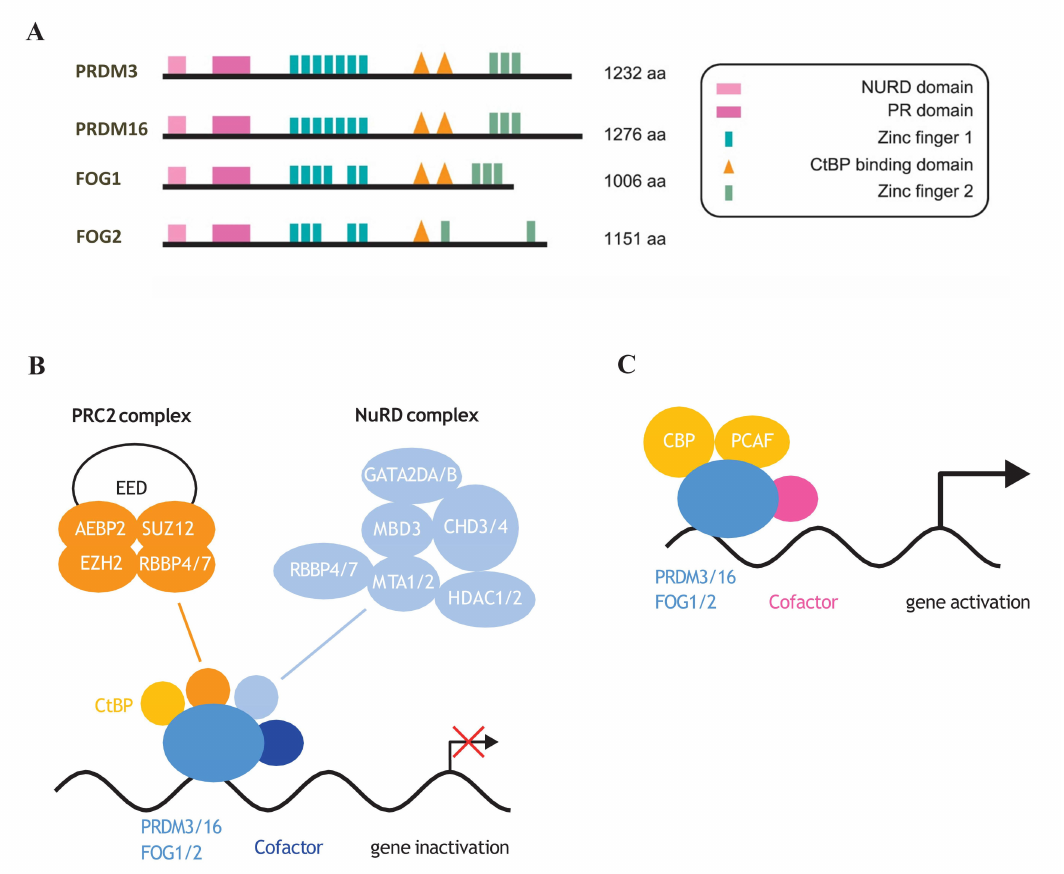
Figure 4. Protein structure of NuRD complex-dependent PRDM factors. ( A ) PR domain, CtBP binding sites, zinc fingers as well as NuRD complex binding elements are indicated. ( B ) PRDM3 / 16 and FOG1 / 2 by interaction with CtBP or NuRD complex negatively regulate gene expression during cellular di ff erentiation [15,61,74,167,168]. ( C ) CBP- and PCAF-mediated acetylation of PRDM3 [169,170] increases its transcriptional activity